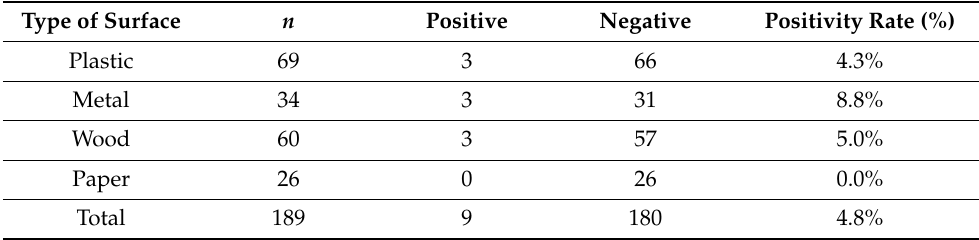
Table 2. Number of SARS-CoV-2RNA positive and negative samples by type of surface and the positivity